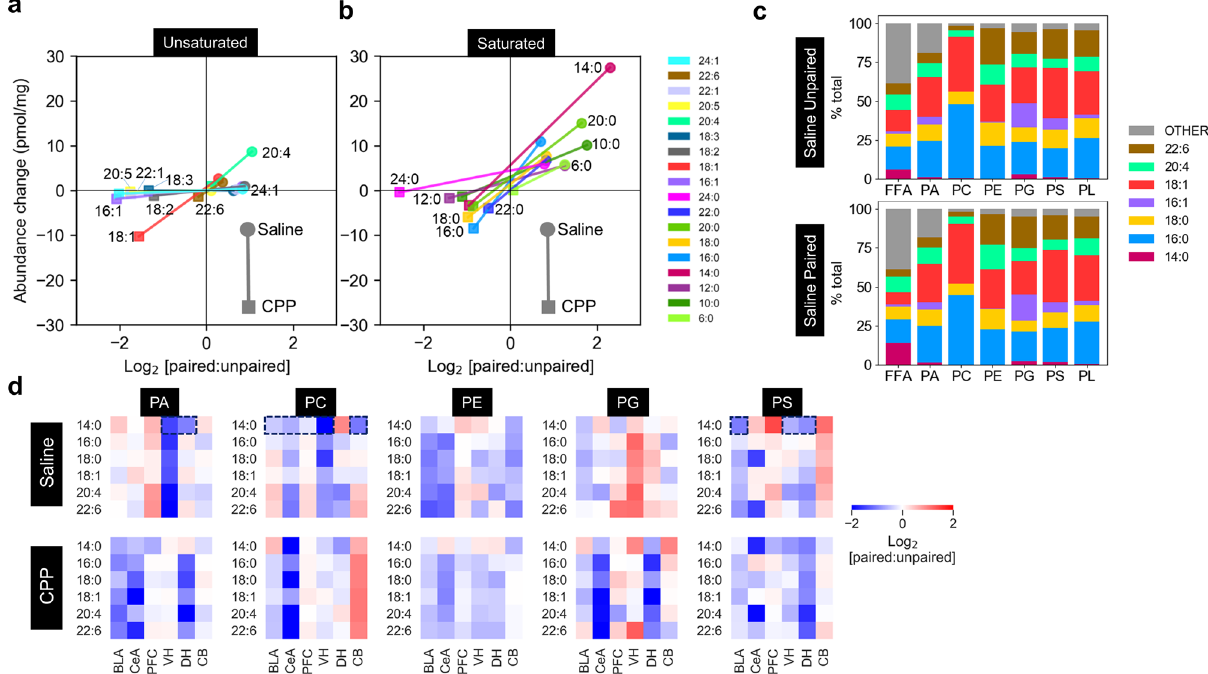
Fig. 4 Myristic acid (C14:0) dominates the FFA response to AFC. a , b Unsaturated and saturated FFAs in the central amygdala. Scatterplots show the AFC-induced absolute ( y axis) and log 2 fold change ( x axis) in mean abundance for each FFA in saline- (round) and CPP- (square) treated animals. For all FFAs, CPP treatment resulted in a decreased response to paired AFC. c Most common acyl chain distribution across FFA and phospholipid class. Each coloured bar represents the summed abundance of all lipids containing a given acyl chain as a percentage of the summed abundance of all acyls for each lipid class. d Response of phospholipids containing the most common acyl chains. Each pixel in the heatmap represents the AFC-induced change in summed abundance of those species in each class containing a given acyl chain. Dotted boxes indicate brain regions where AFC induces a decrease in myristoyl containing phospholipids that could potentially represent substrates for phospholipase A mediated release of myristic acid. CeA — central amygdala, BLA — basolateral amygdala, PFC — prefrontal cortex, VH — ventral hippocampus, DH — dorsal hippocampus, CB — cerebellum, PA — phosphatidic acid, PC — phosphatidylcholine, PE — phosphatidylethanolamine, PG — phosphatidylglycerol, PS — phosphatidylserine. Source data are provided as a Source Data fi